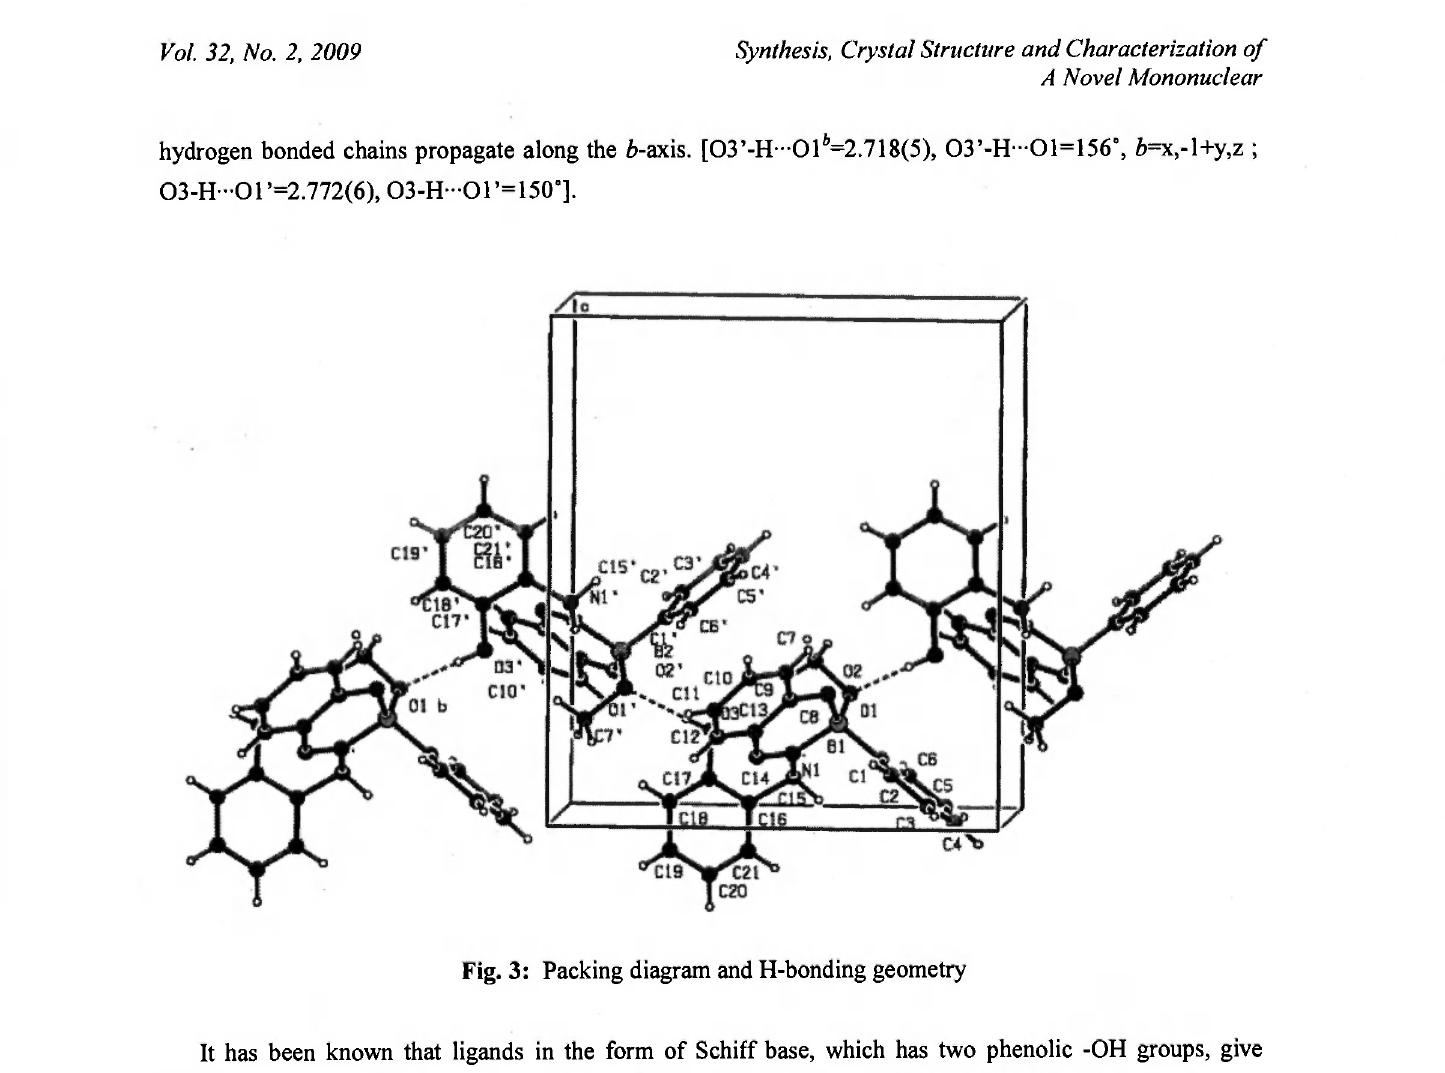
Fig. 3: Packing diagram and Η-bonding